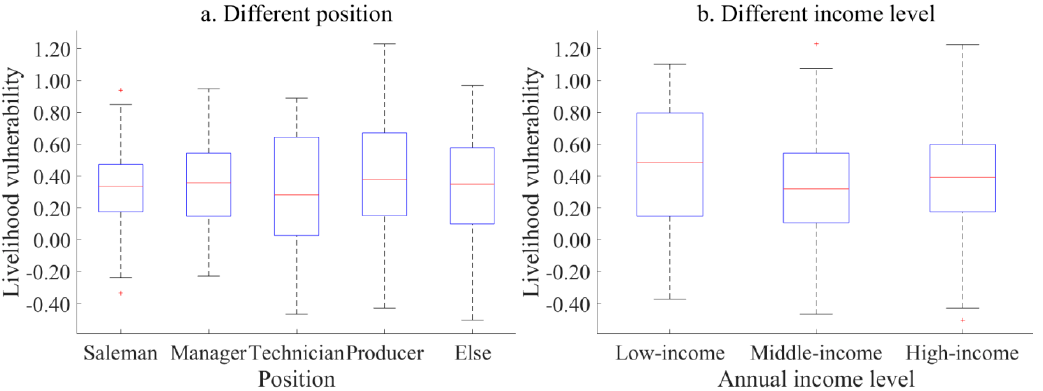
Figure 4. Livelihood vulnerability index for employees of different positions and income levels.